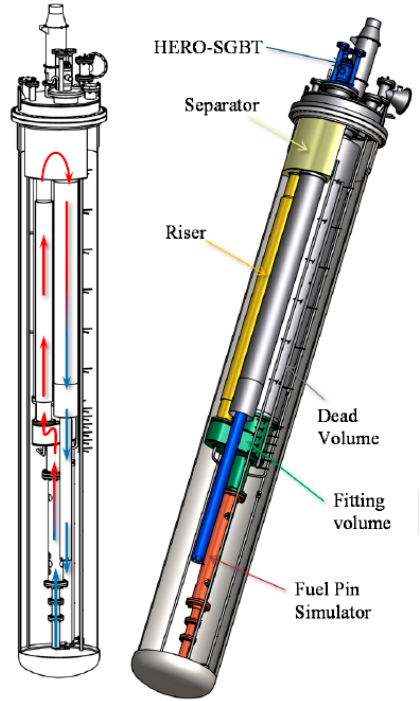
Figure 1. Schematic view of the CIRCE-HERO facility.